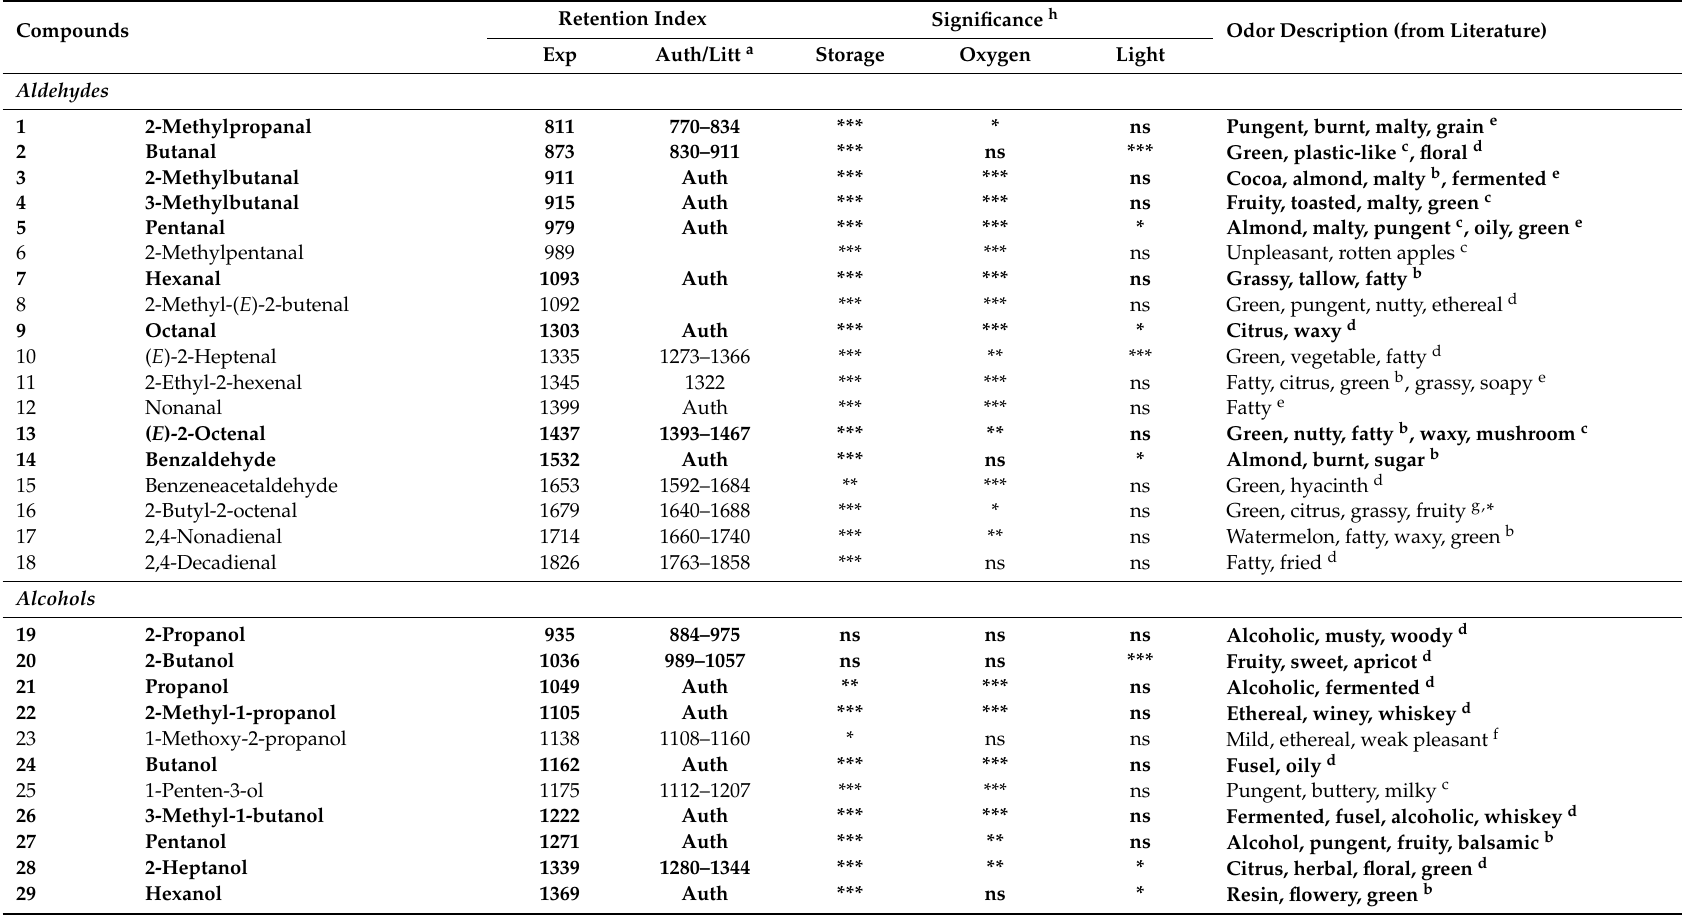
Table 2. Volatile compounds identified by Gas Chromatography-Mass Spectrometry (GC-MS) in the packed milled Roselle ( Hibiscus sabdariffa L.) seeds stored for seven months in the presence or absence of oxygen and under different light conditions (light or darkness). Volatiles in bold were detected in our previous work on aroma profile of Roselle seeds